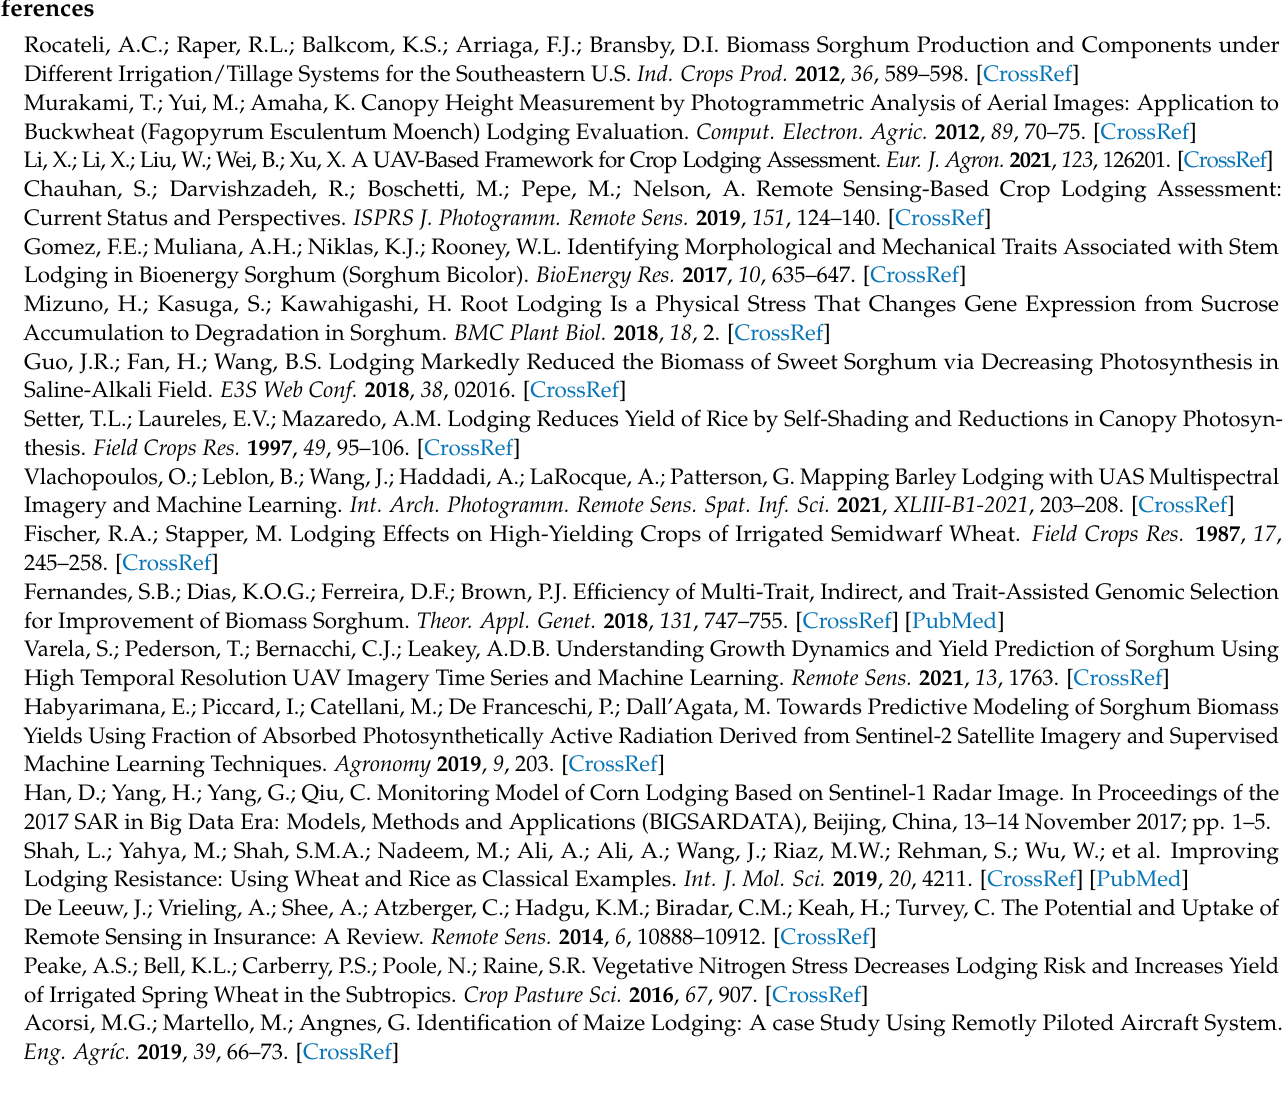
Table S1: Description of the 60 CNN models implemented according to combinations of UAV-based image features, CNN architectures, and target